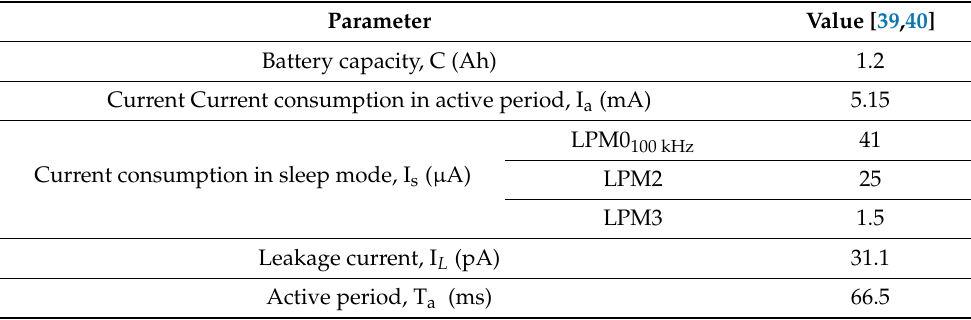
Table 2. Summary of the parameters and values used for battery life estimation.